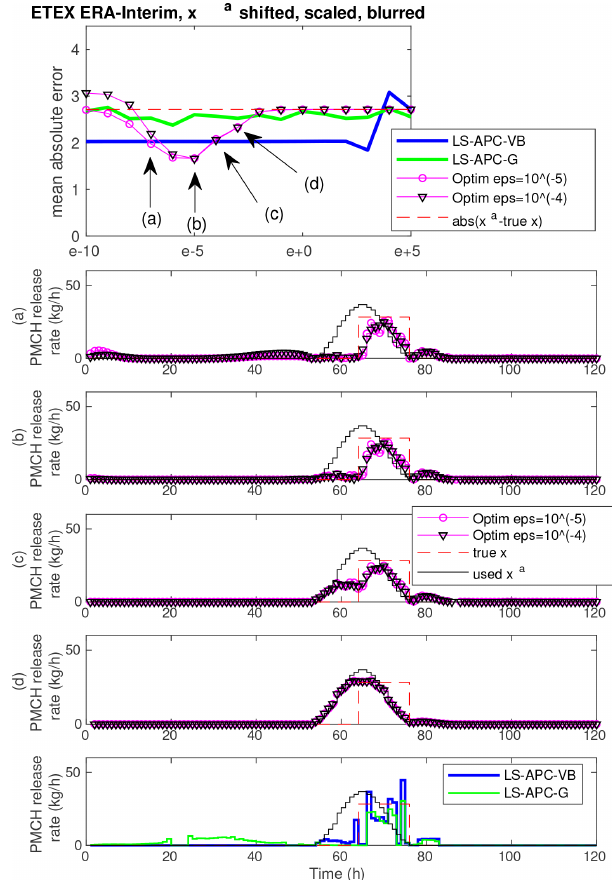
Figure 4. Same as Fig. 3 for the ETEX ERA-Interim dataset with x a shifted, scaled, and